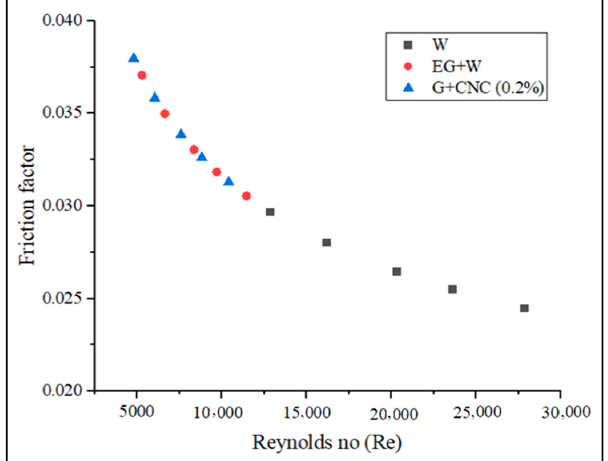
Figure 16. Friction factor vs. Reynolds number (Re).